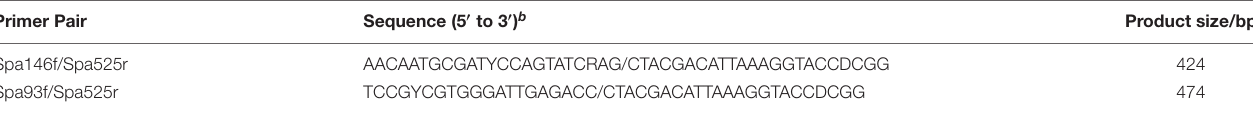
TABLE 1 | Two S. parasanguinis -specific primer pairs based on the groEL gene a . Primer Pair Sequence (5 (cid:48) to 3 (cid:48) )